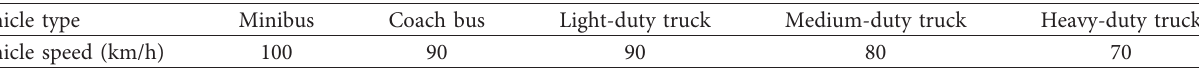
Figure 3: Installation of the field sensor for the vehicle pretest system. Table 3: Calibration for speeds of different types of vehicles in the baseline state.